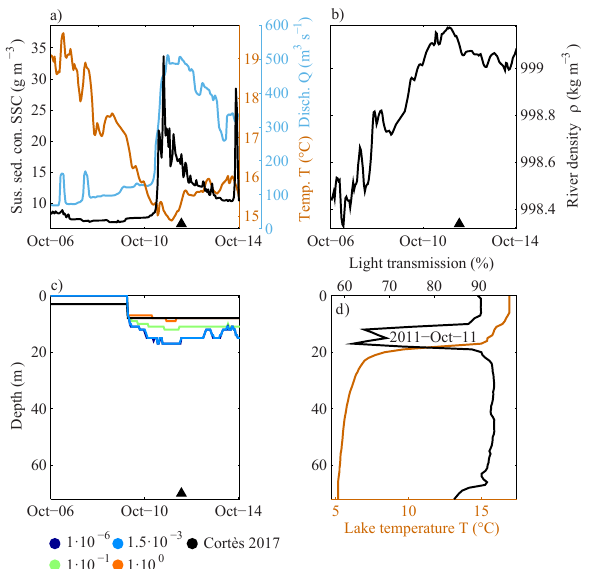
Figure A4. River intrusion entrainment sensitivity analysis for the LB/Aare system in December 2009. (a) SSC (black), tempera- ture ( T ; orange) and river discharge ( Q ; blue) from Aare station no. 2085. (b) River density at station no. 2085 obtained from T and SSC in (a) . (c) River intrusion depth calculated from Appendix A with varying entrainment constant β (Eq. A13); light green denotes the value used in this study; black indicate intrusion depth modeled as in Cortés et al. (2014). (d) Vertical measurements of T and light transmission in LB for 9 December 2009. The triangles in (a) – (c) mark the time of the vertical profile in (d)